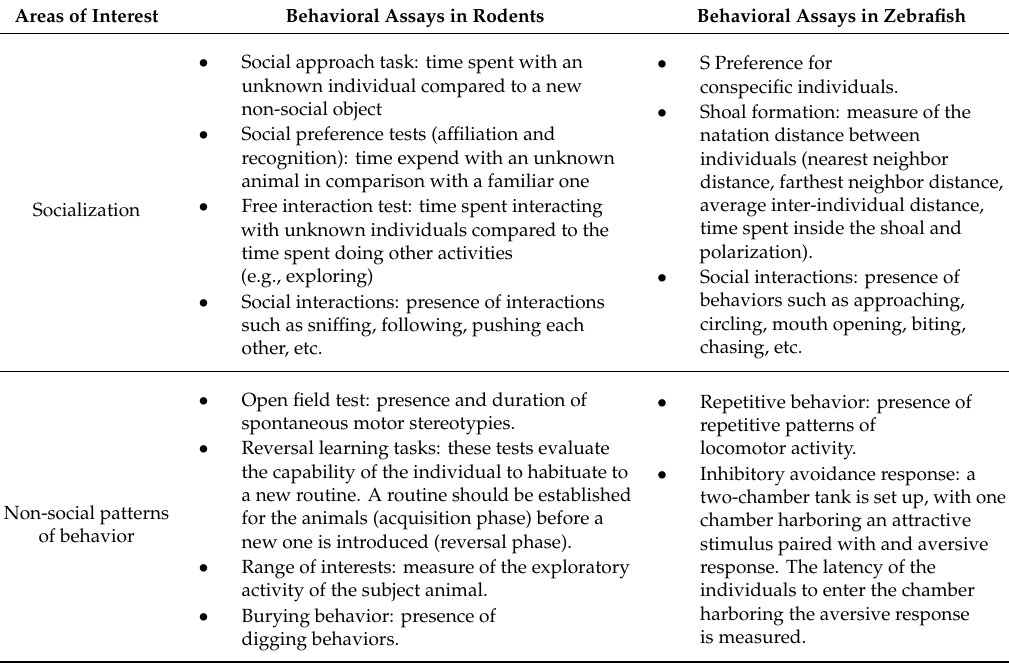
Table 4. Assays to evaluate the presence of ASD-like alterations in model organisms (rodents and zebrafish). The behavioral assays are focused on detecting alterations in the three core areas a ff ected in ASD-patients: socialization, non-social patterns of behavior (including repetitive behavior, motor alterations and limited range of activities) and communication